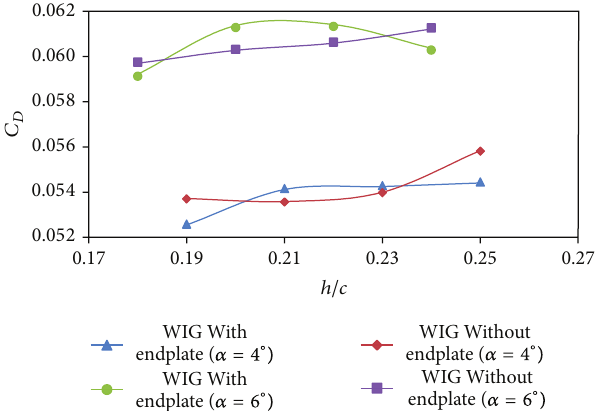
Figure 9: Moment coefficient ( 𝐶 𝑀 ) of WIG craft model with and without endplates versus ground clearance ( ℎ/𝑐 ) at different angles of attack.